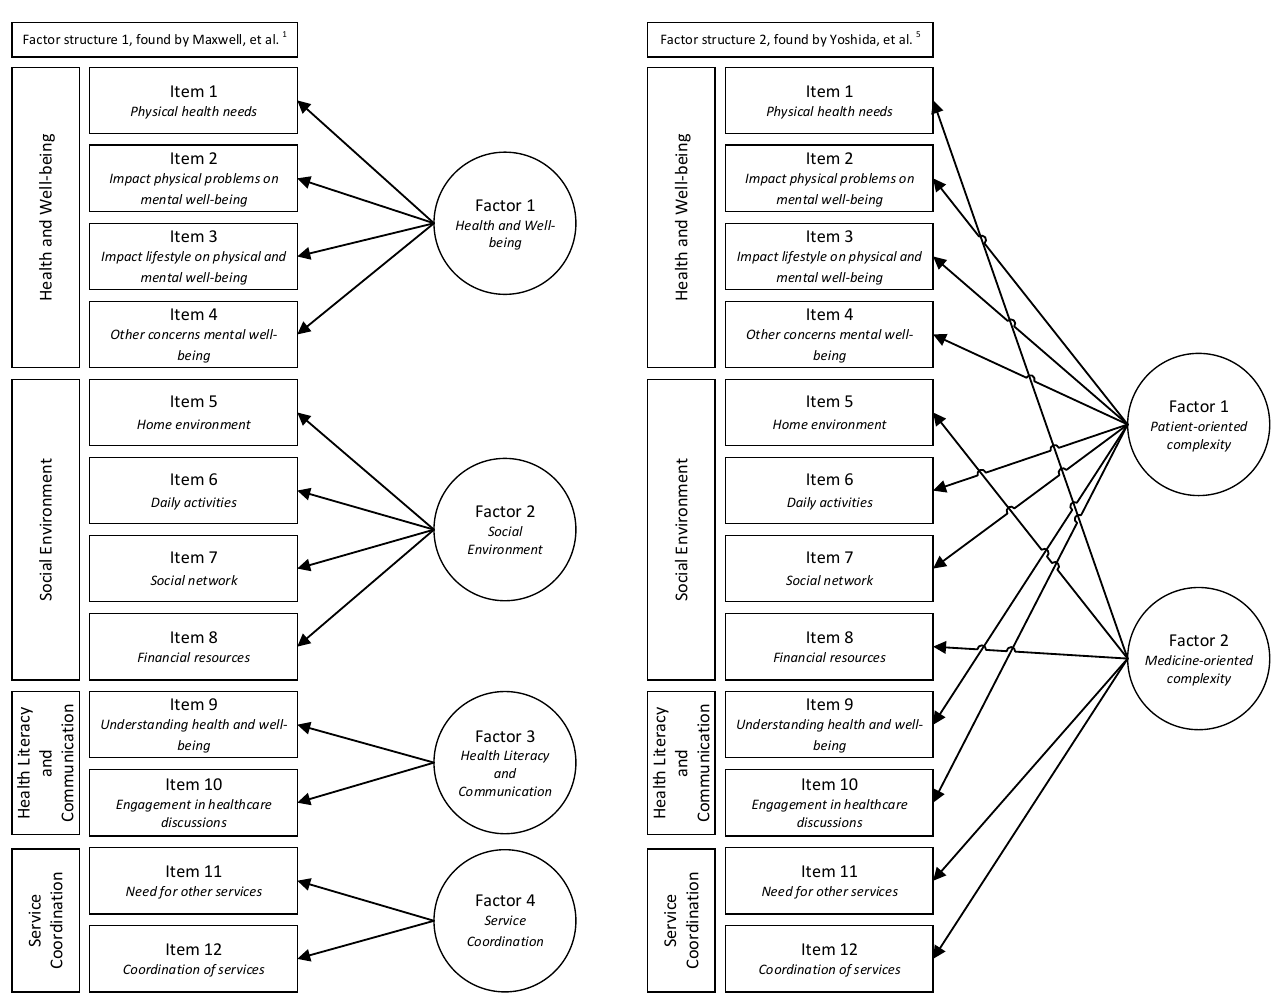
Figure 1. Overview of the two different factor structures as identified for the PCAM. Due to the low ratio of items per factor of each structure, we handled missing data by listwise deletion. The CFA was conducted using the robust WLS estimator [28]. For each of the two factor structures, the following parameters were calculated and compared to assess what structure best fits the PCAM data. Factor loadings and standard errors of each PCAM item in relation to the assigned factor were derived from the CFA output. Loadings